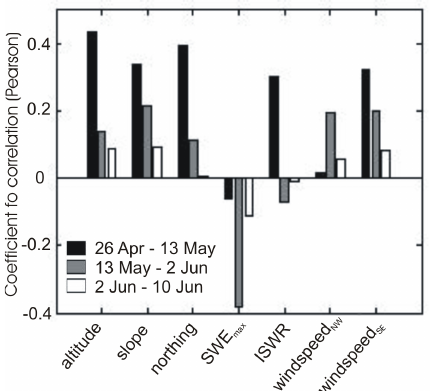
Fig. 10. Coefficient of correlation (Pearson) for daily ablation rates for each time period against altitude, slope, northing, SWE at the end of the accumulation season ( SWE max ) , incoming short- wave radiation for each period ( ISWR ) and windspeed for prevailing wind direction north-west ( windspeed NW ) and south-west ( wind- speed SW ).